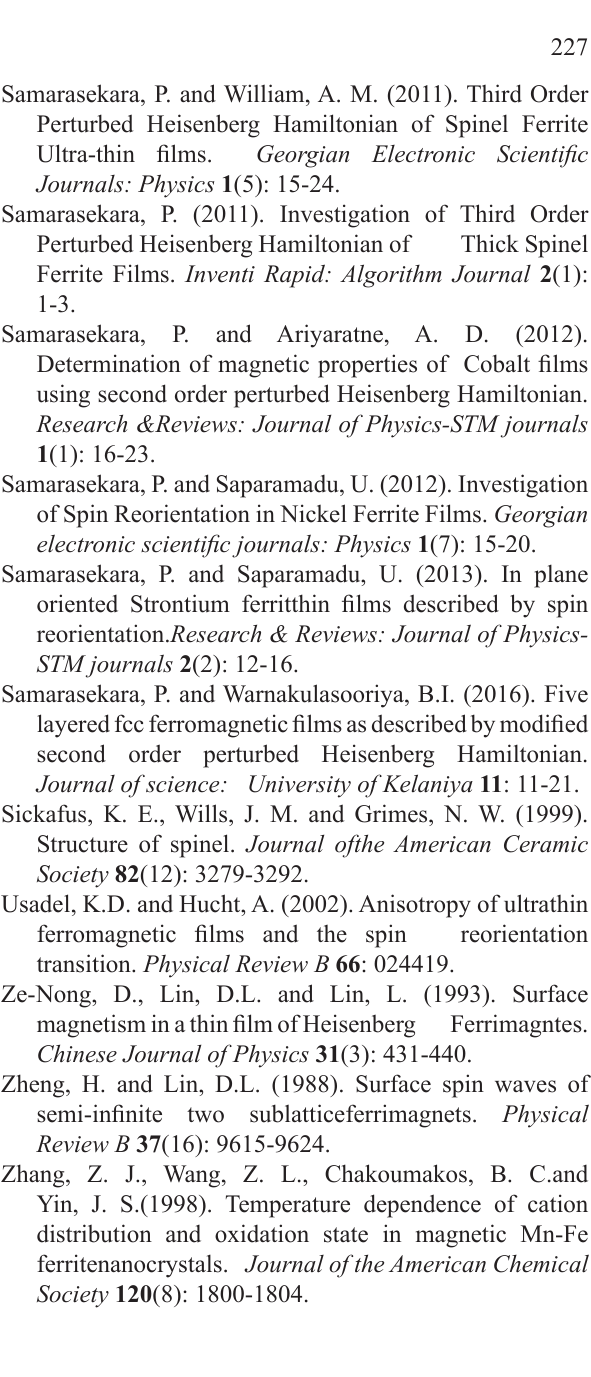
Figure 3: 3-D plot of energy versus angle and stress induced anisotropy for N =